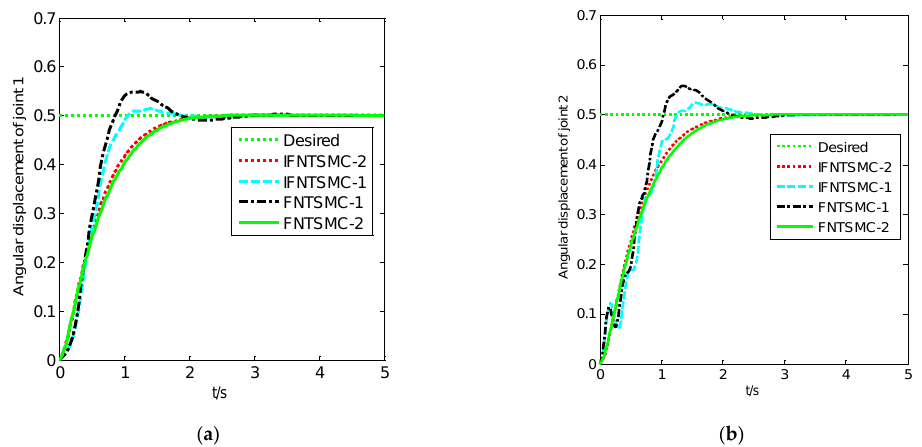
Figure 4. The joint angular displacement. ( a ) Angular displacement of joint 1, ( b ) Angular displace- ment of joint 2.